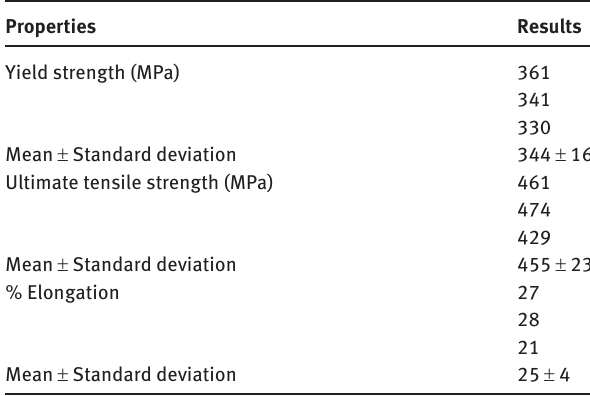
Table 1: Chemical composition of tube sample (mass%) Elements